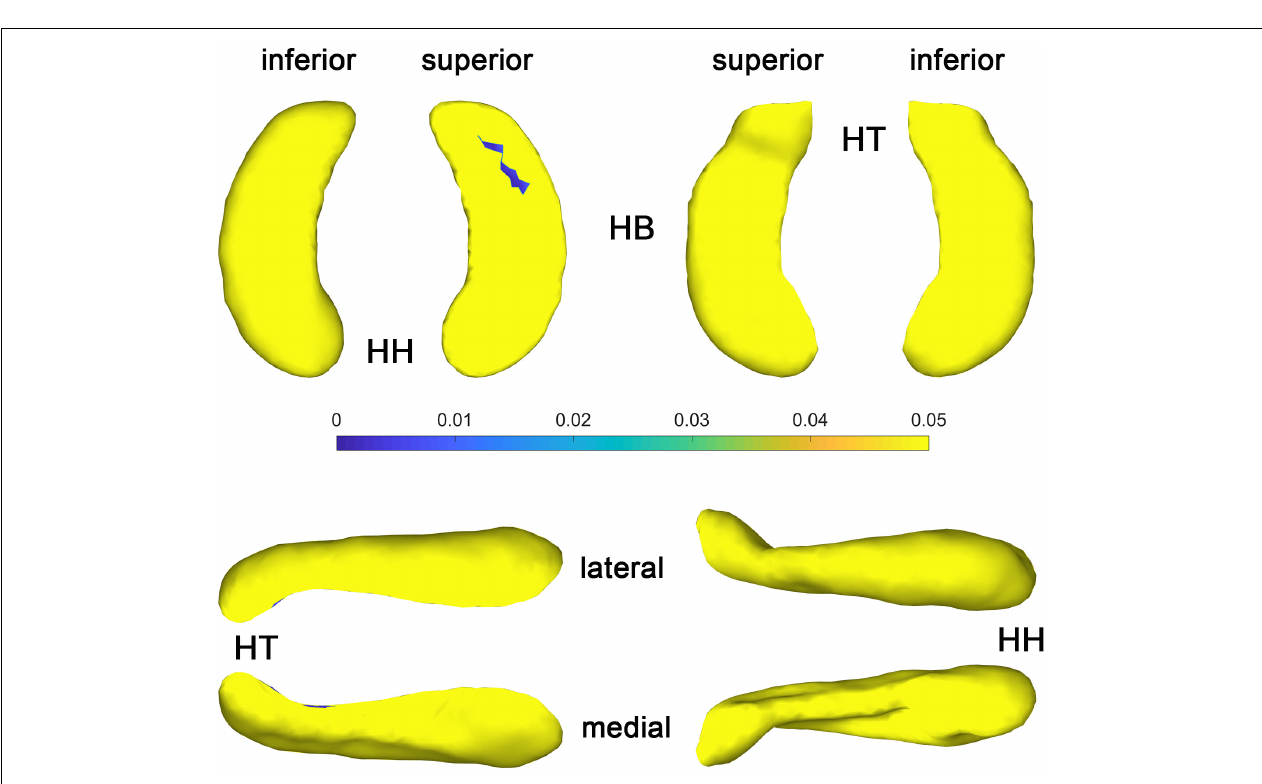
FIGURE 4 | P value maps of congenital blind subjects compared with control group after FDR correction, from left to right columns are p value maps of left and right HF, respectively, p < 0.05 was considered as statistically significant. HH, hippocampal head; HB, hippocampal body; HT, hippocampal tail.